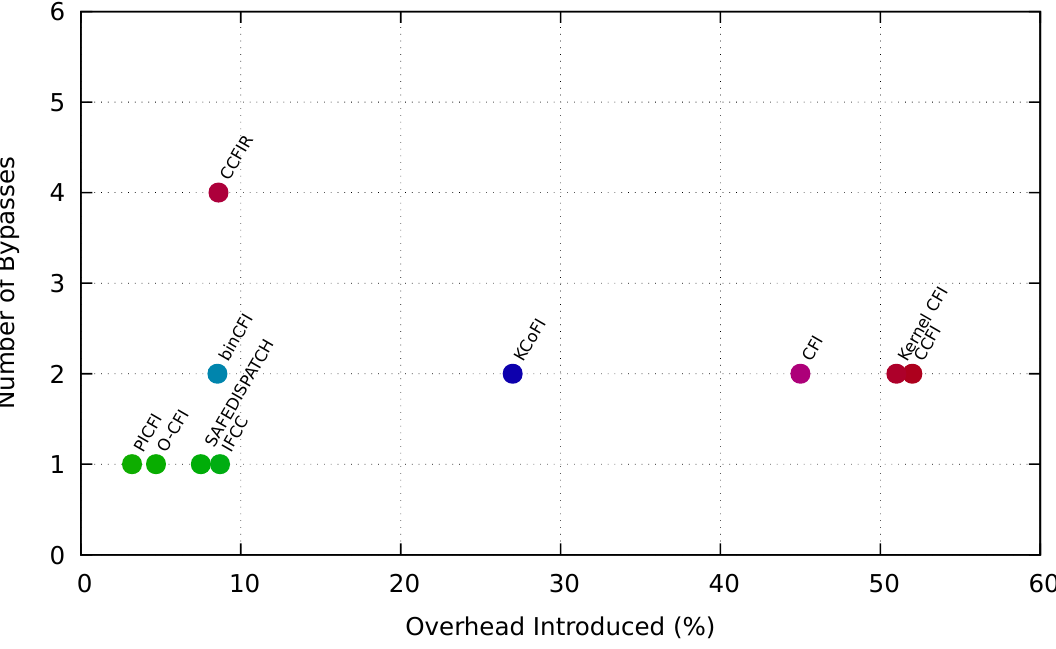
Figure 3. CFI techniques with attack vector counts versus